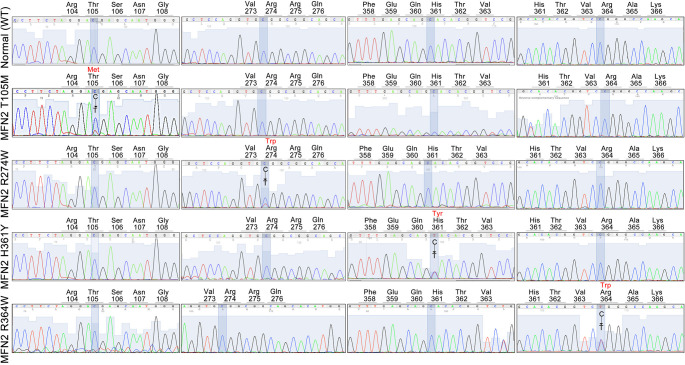
Genotyping of CMT2A patient cells.Each cell line underwent Sanger sequencing for all 4 MFN2 mutation loci. A representative (of 3) normal control lines is shown. Shaded areas show each mutation locus. Encoded amino acids are on top; red amino acid is mutant form.